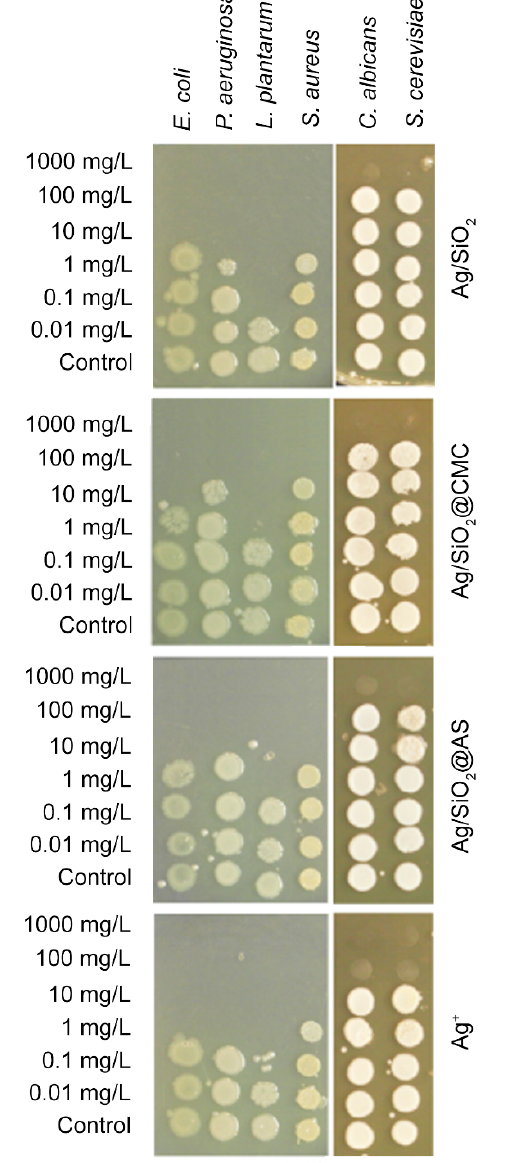
Figure 8. The ability of the Gram-negative ( Escherichia coli, Pseudomonas aeruginosa ), Gram-positive bacteria ( Lactobacillus plantarum , Staphylococcus aureus) and yeast strains ( Candida albicans , Saccharomyces cerevisiae ) to form a colony after a 24 h exposure to the Ag / SiO 2 , Ag / SiO 2 @CMC, Ag / SiO 2 @AS, and Ag + -ions (reference). After exposure, the cells (5 µ L) were transferred onto a toxicant-free agarized growth medium. The lowest concentration (mg / L), providing total microbial growth inhibition was considered minimum biocidal concentration (MBC).